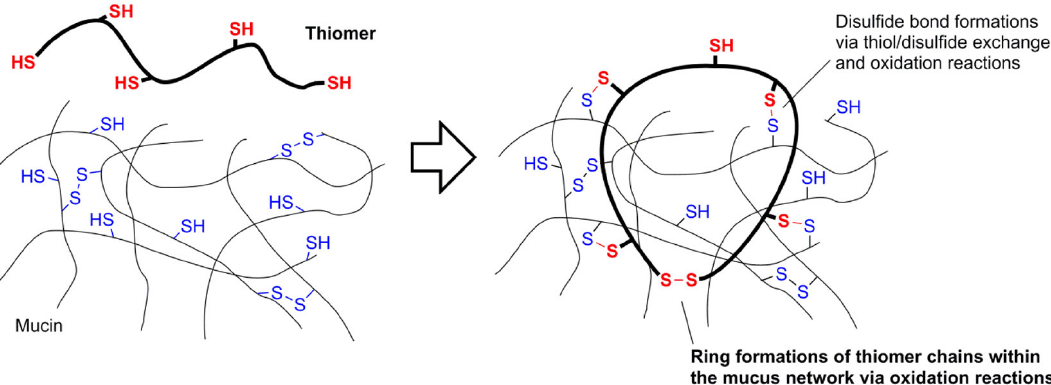
Figure 9. Cartoon showing key reactions and processes occurring during mucoadhesion. Reprinted with permission from [2]. Copyright (2019) Elsevier B. V.